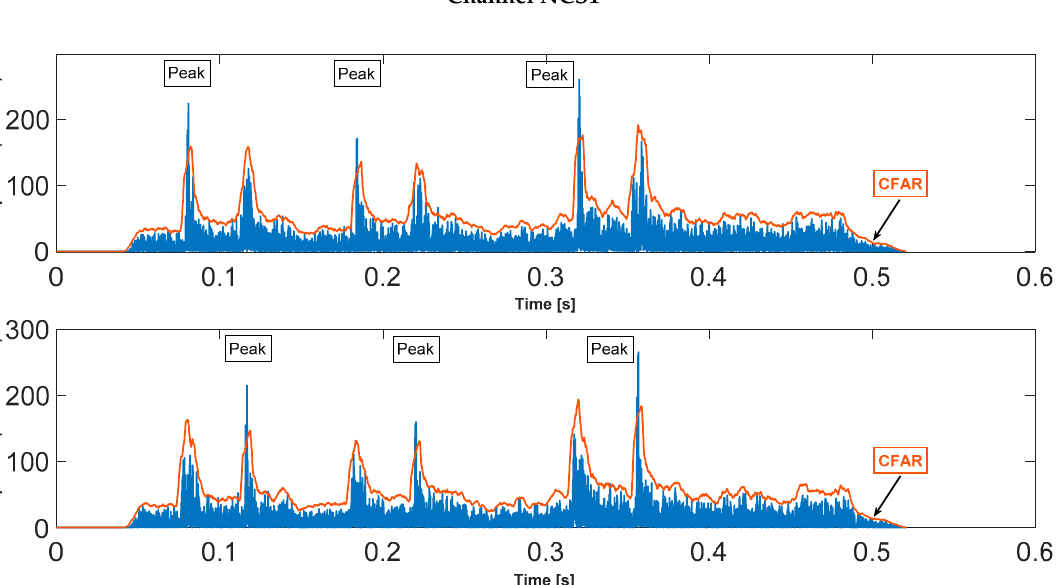
Figure 7. Correlation functions for the received signal on channel NCS1 (SNR = − 3 dB, T PS = 4 ms). The results of the determined Preamble Error Rate (PER) values for different values